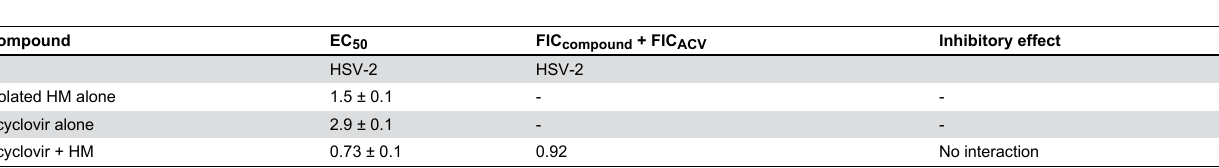
The interaction between HM and ACV was interpreted according to the combined FIC index [FIC compound + FIC ACV ] as synergy (≤0.5), no interaction (0.5 - 4) or antagonism (>4)